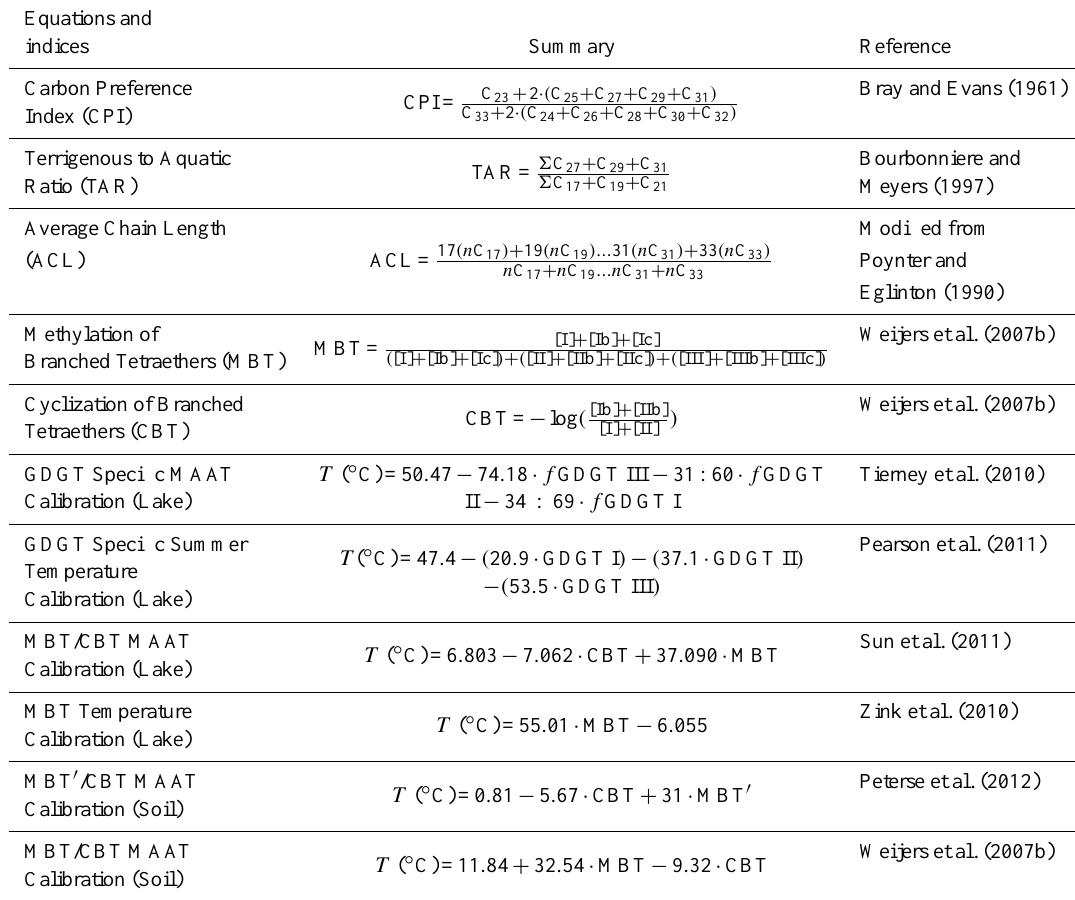
Table 1. Equations and indices used in this study. Equations